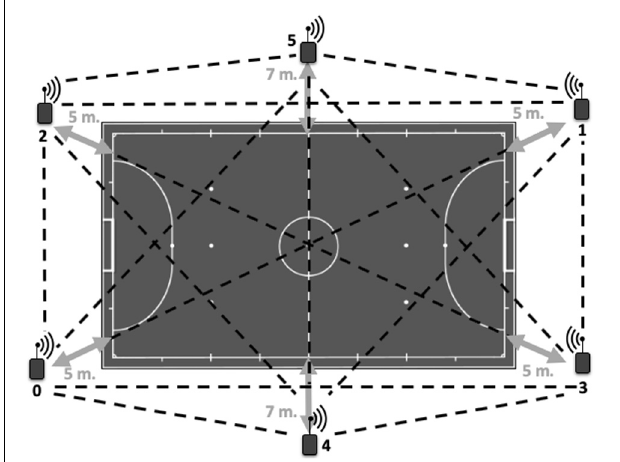
FIGURE 1 | Antennae distribution of Local Positioning System on futsal pitch (Serrano et al.,